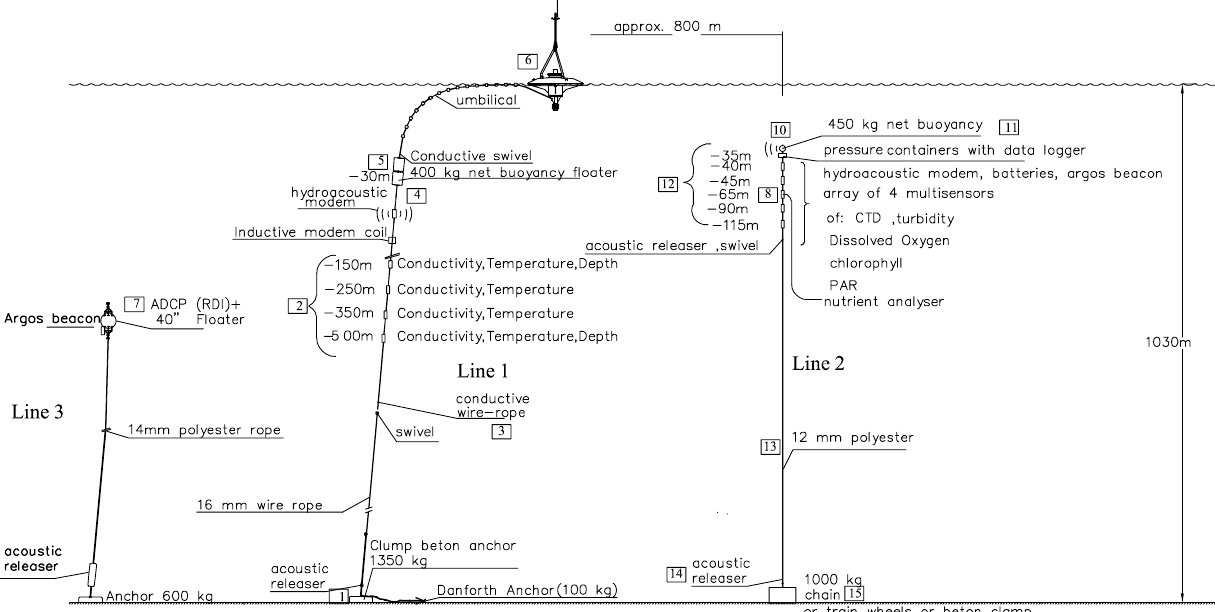
Fig. 2. M3A mooring